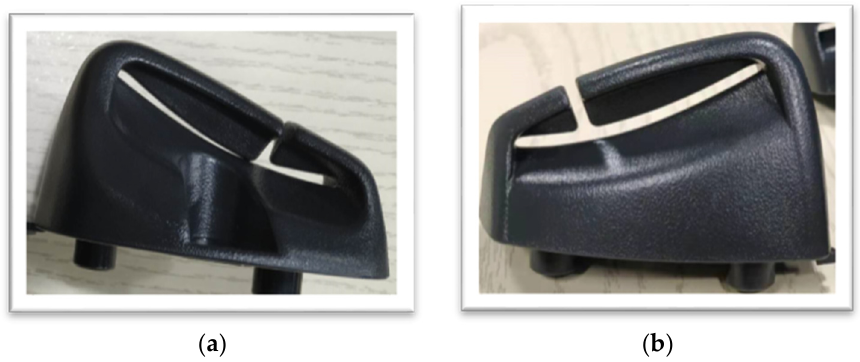
Figure 9. Improving Experiment with different GF and Holding.